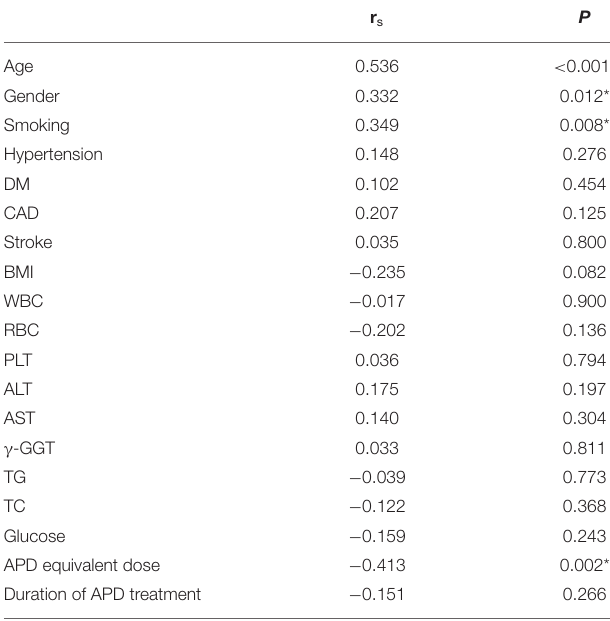
Frontiers in Cardiovascular Medicine |